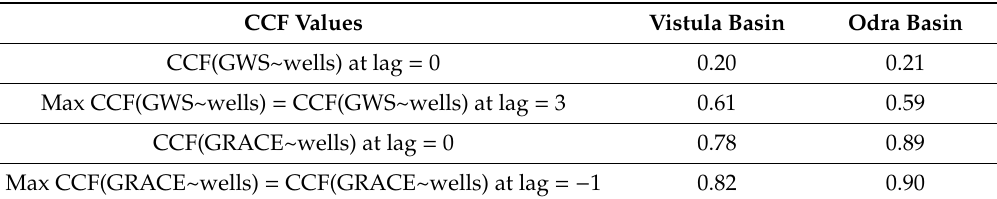
Figure 3. Average thickness of the unsaturated zone at the location of the well, gravity recovery and climate experiment (GRACE) / NOAH GWS and GRACE terrestrial water storage (TWS) anomalies on the area of Vistula basin ( a ) and Odra basin ( b ). Table 1. Cross-correlation function (CCF) values between the thickness of the unsaturated zone at the location of the well and GWS or GRACE TWS values.